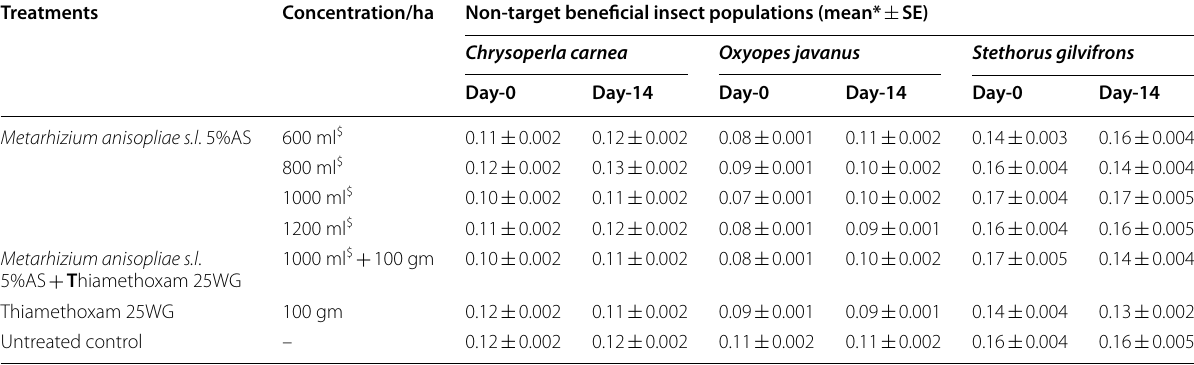
Table 3 Effect of Metarhizium anisopliae s.l. 5%AS on non-target beneficial organisms in tea gardens